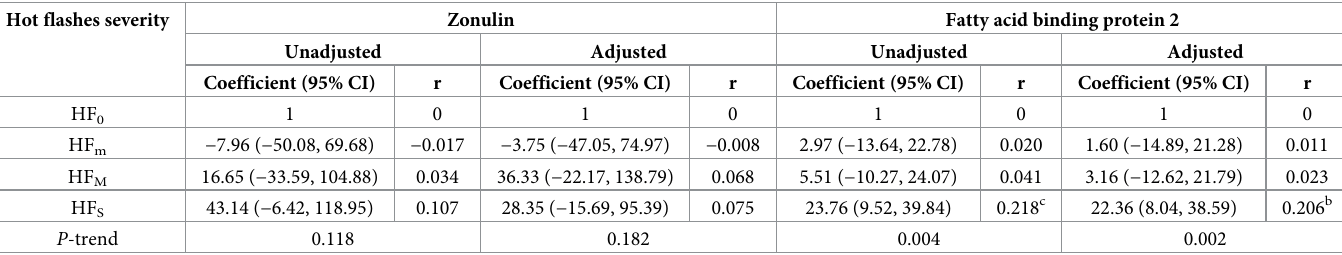
Table 2. Associations between hot flashes and zonulin and fatty acid binding protein 2. Hot flashes severity Zonulin Fatty acid binding protein 2 Unadjusted Adjusted Unadjusted Adjusted Coefficient (95% CI) r Coefficient (95% CI) r Coefficient (95% CI) r Coefficient (95%